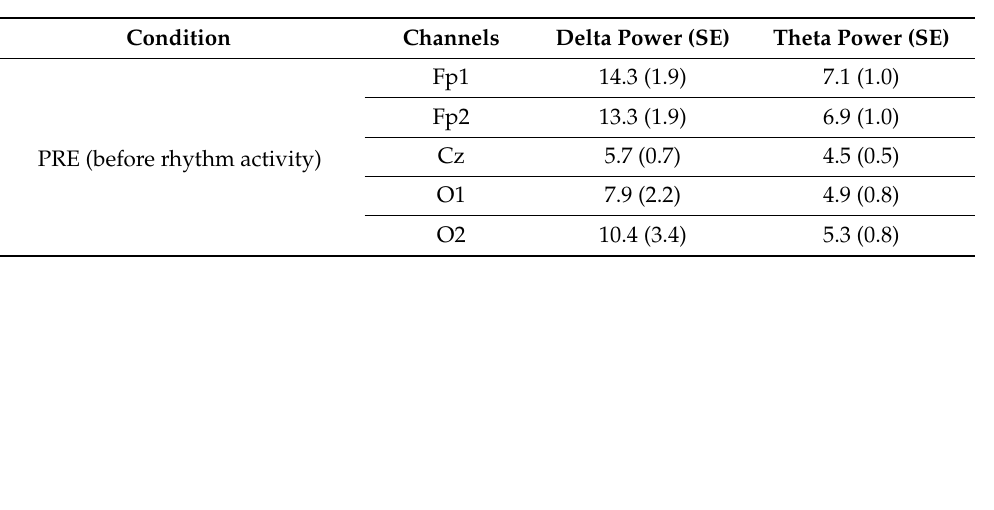
Table A1. Marginal Means and Standard Errors of Wavelet Power in PRE and POST